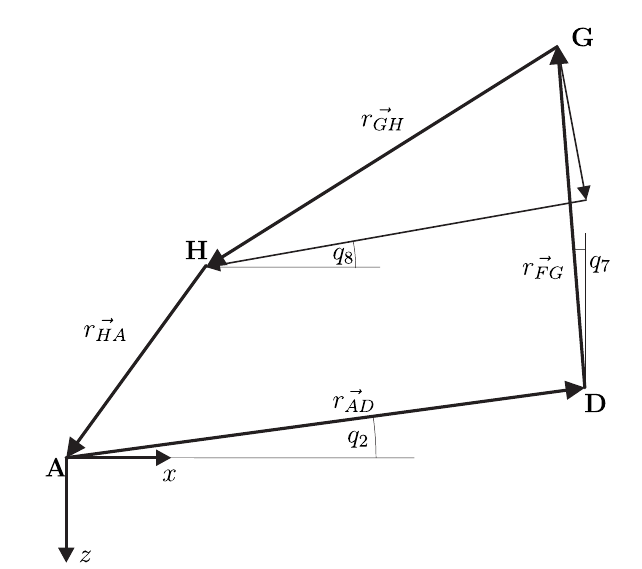
Figure B1. Convergence of the maximum bending stress in a single hinge (deflection angle ≈ 0 . 1 ◦